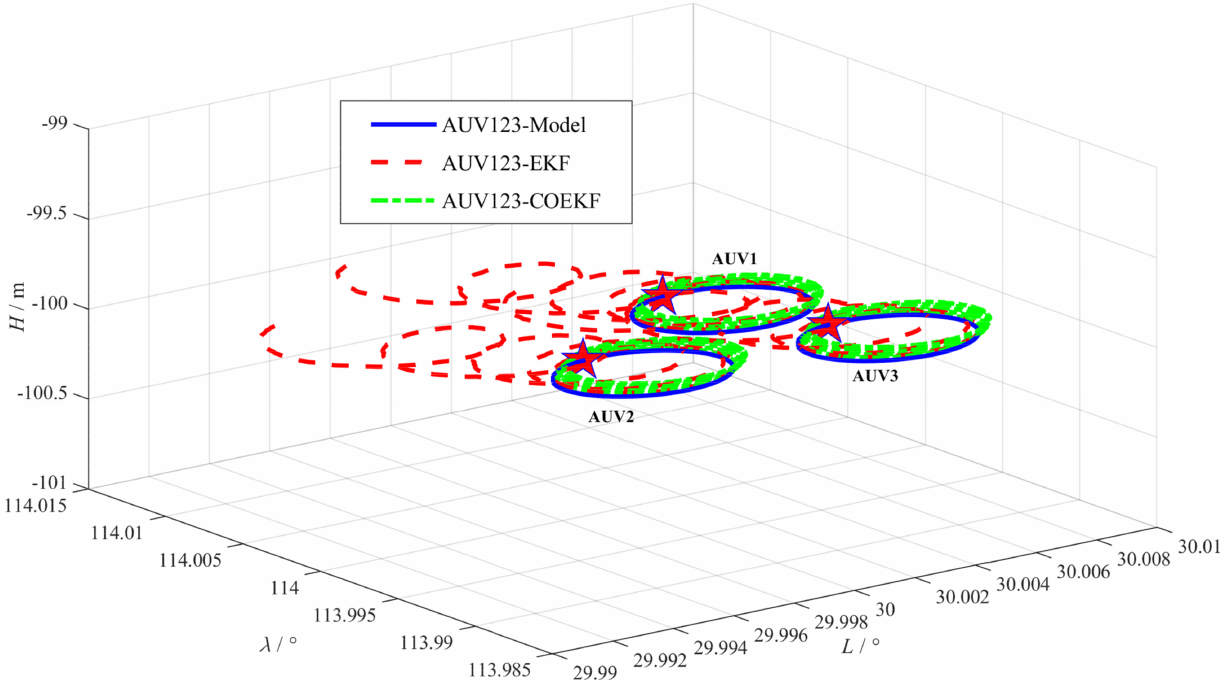
Figure 3. The estimated trajectories of three